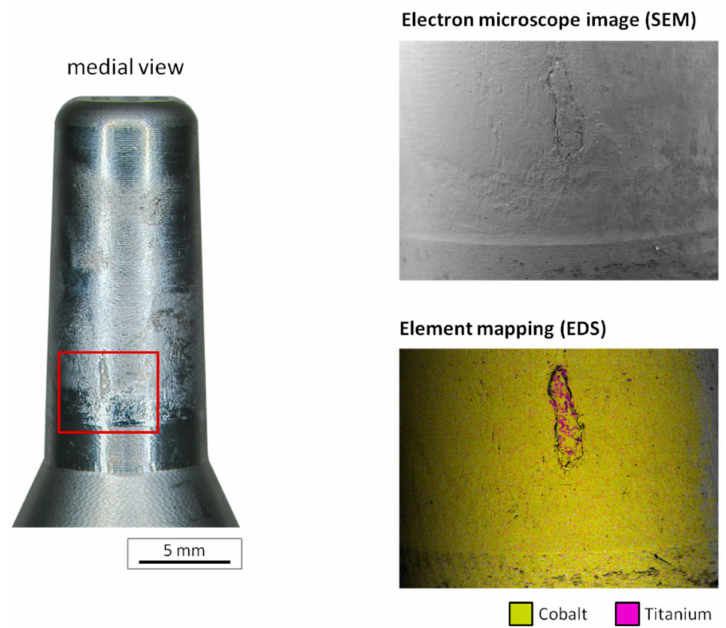
Figure 3. SEM and EDS analysis of the medial contact area of one symptomatic retrieved CoCr neck adapter (Case #3). The SEM and EDS-analysis indicated that the local damage of the protective oxide layer and the suppressed repassivation process led to fretting wear and contact corrosion with metal dissolution in the medio-proximally and latero-proximally contact area of the retrieved neck adapter. Furthermore, local material deposition on the neck adapter with a high element concentration of titanium was observed at the circular medial taper interface caused by local adhesion and cold welding in the mixed CoCr / Ti neck-stem junction.